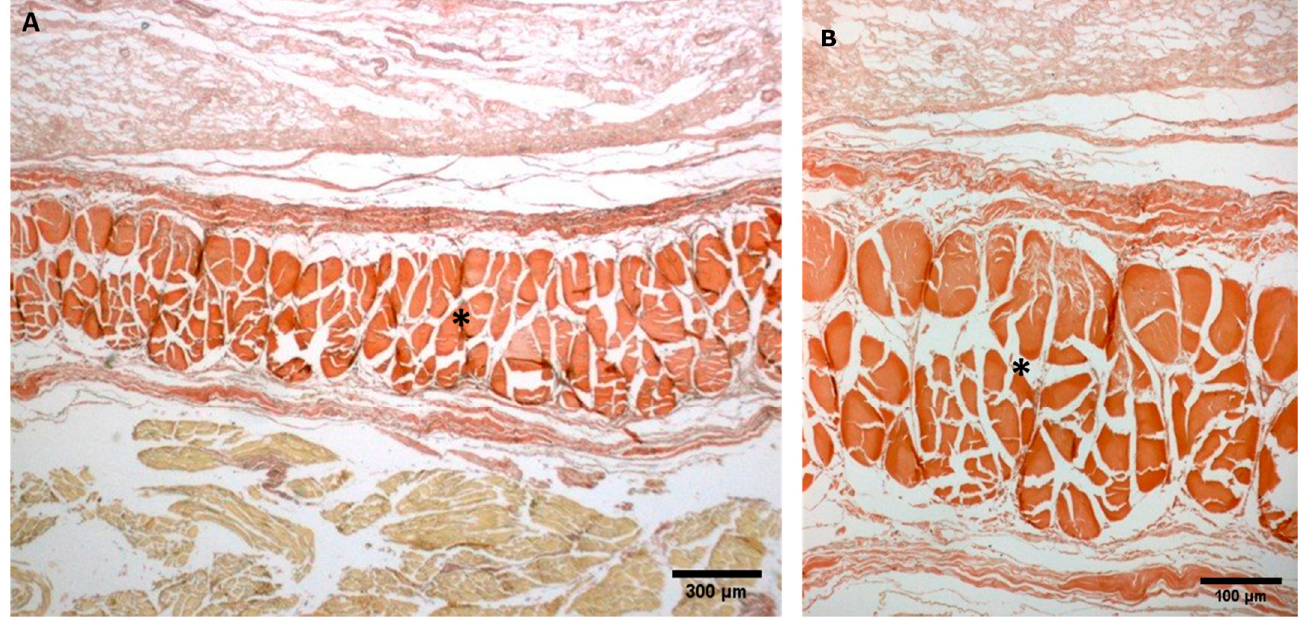
Figure A1. ( A , B ): Histological images (Weigert Van Gieson staining): (*) Lateral deep fascia of the thigh in adult.